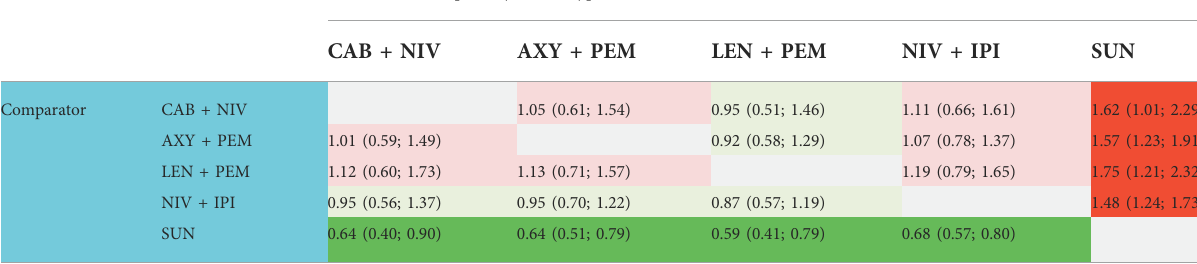
Thevaluesineachcellrepresenttherelativetreatmenteffectfortheinterventiononthetopwhencomparedtotheinterventionontheleft.Greensuggestsarelativetreatmentbene fi t(light greenanonsigni fi cantbene fi t,anddarkgreenasigni fi cantbene fi t).Redsuggestsarelativetreatmentharm(lightredanonsigni fi cantharm,anddarkredasigni fi cantharm).AXY,axitinib; CAB, cabozantinib; IPI, ipilimumab; LEN, lenvatinib; NIV, nivolumab; PEM, pembrolizumab; SUN, sunitinib